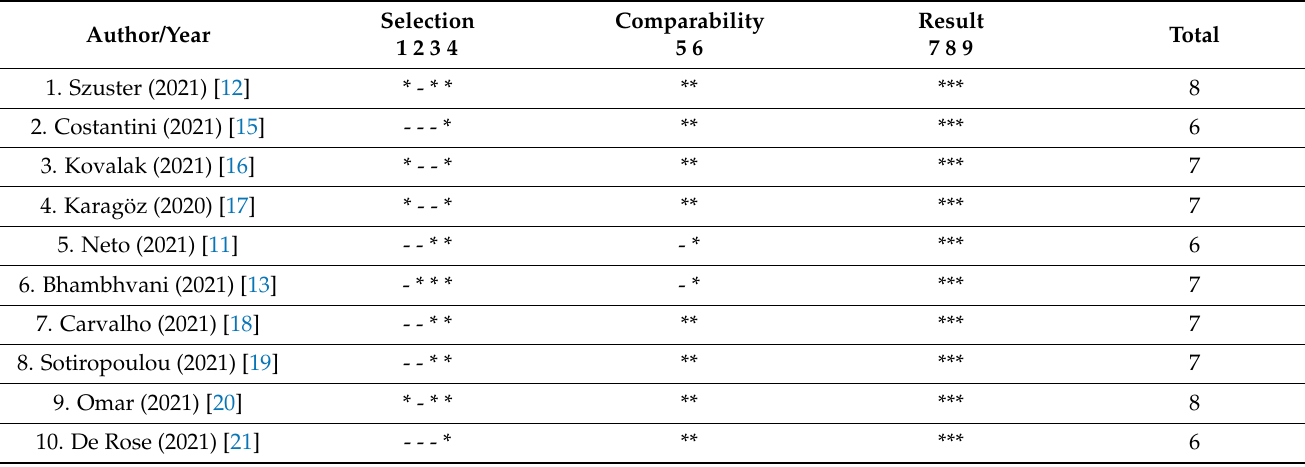
Table 2. Methodological Quality of the included